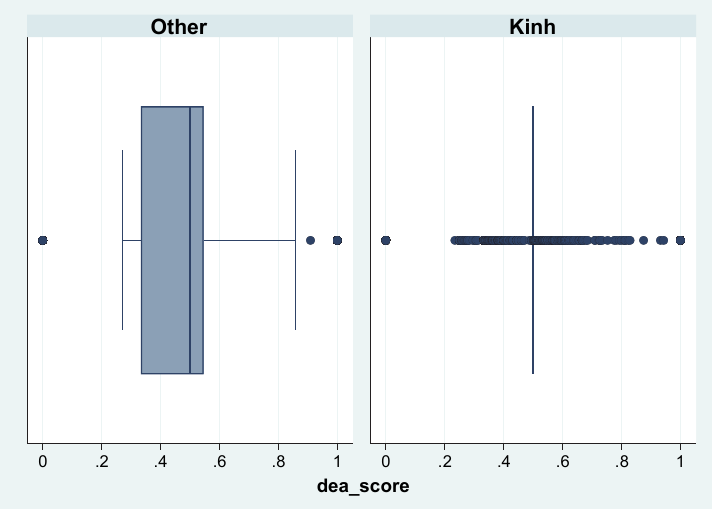
Source: Analysis results